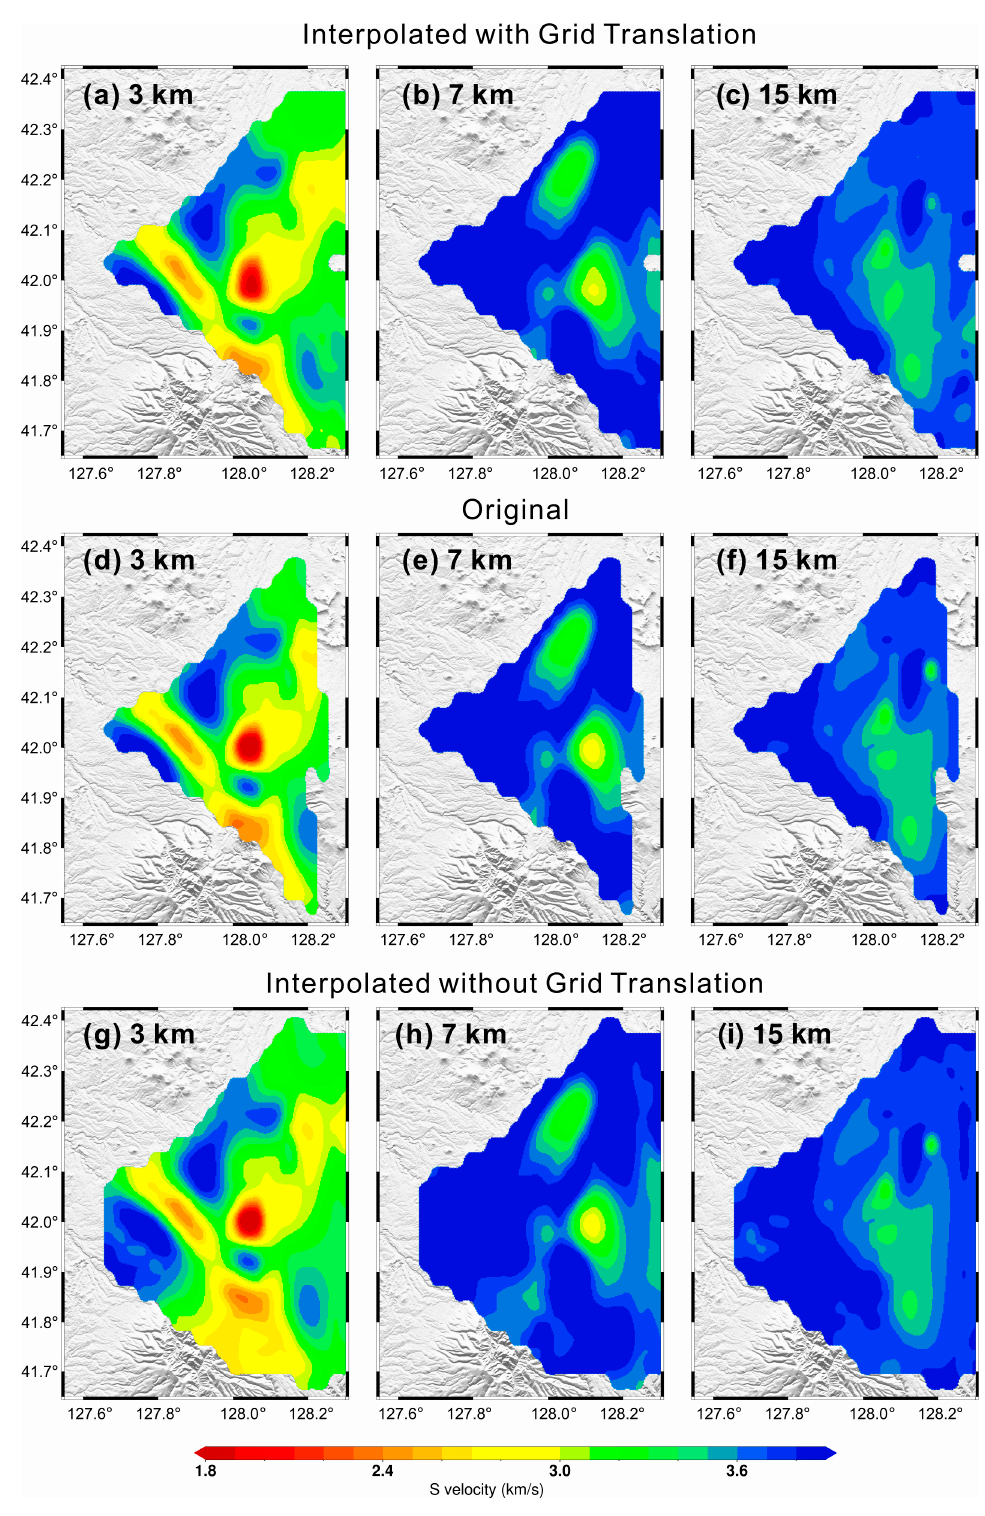
Figure 4. Results at different depths: ( a – c ) Interpolated results with grid translation; ( d – f ) original results inverted by CPS330; and ( g – i ) combination of the interpolation results and the original results (inverted by CPS330).